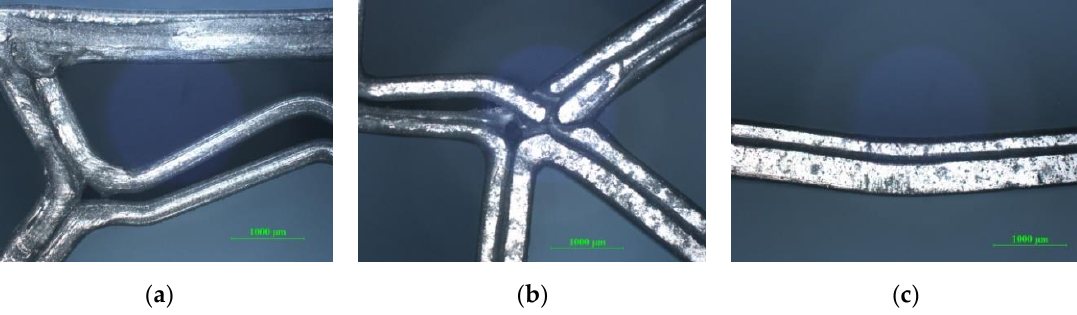
Figure 7. Optical micrographs of failed sandwich specimens subjected to compression tests (magnification 25 × ): ( a ) honeycomb core sandwich specimens; ( b ) diamond-celled core sandwich specimens; ( c ) corrugated core sandwich specimens.